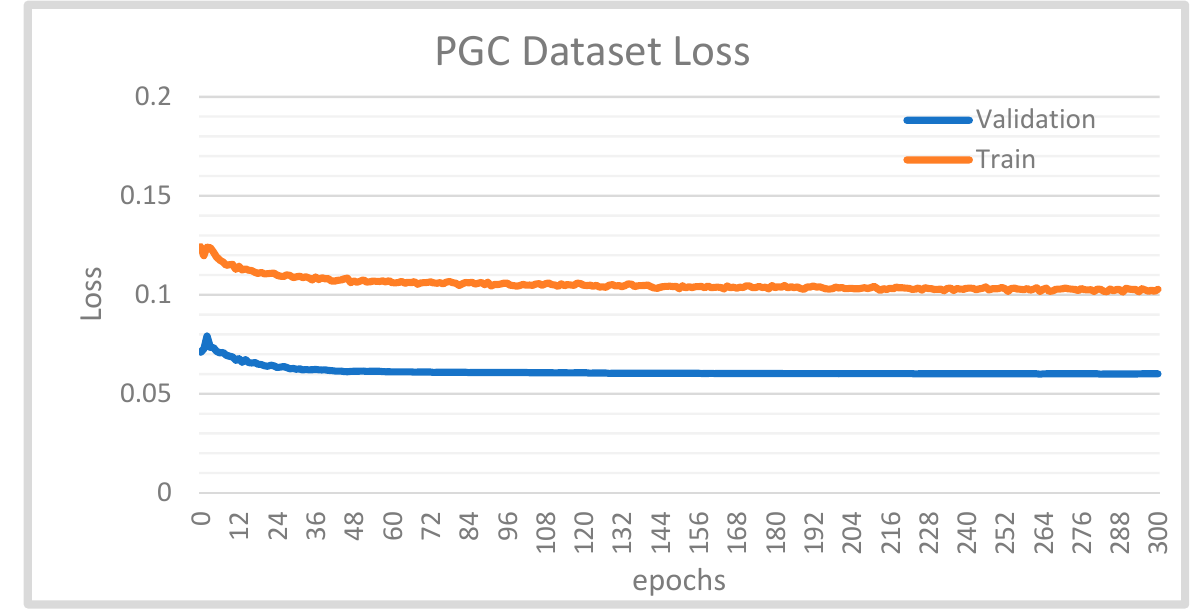
Figure 8. Our dataset loss plots for the training and validation sets.